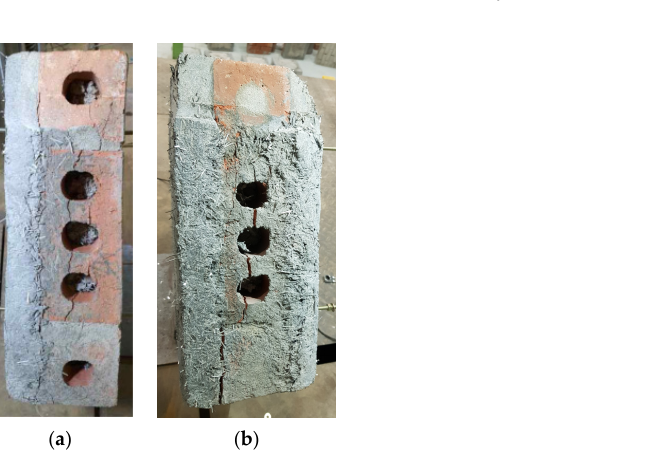
Figure 8. Damage state observed on front or back side after termination of diagonal tension tests: